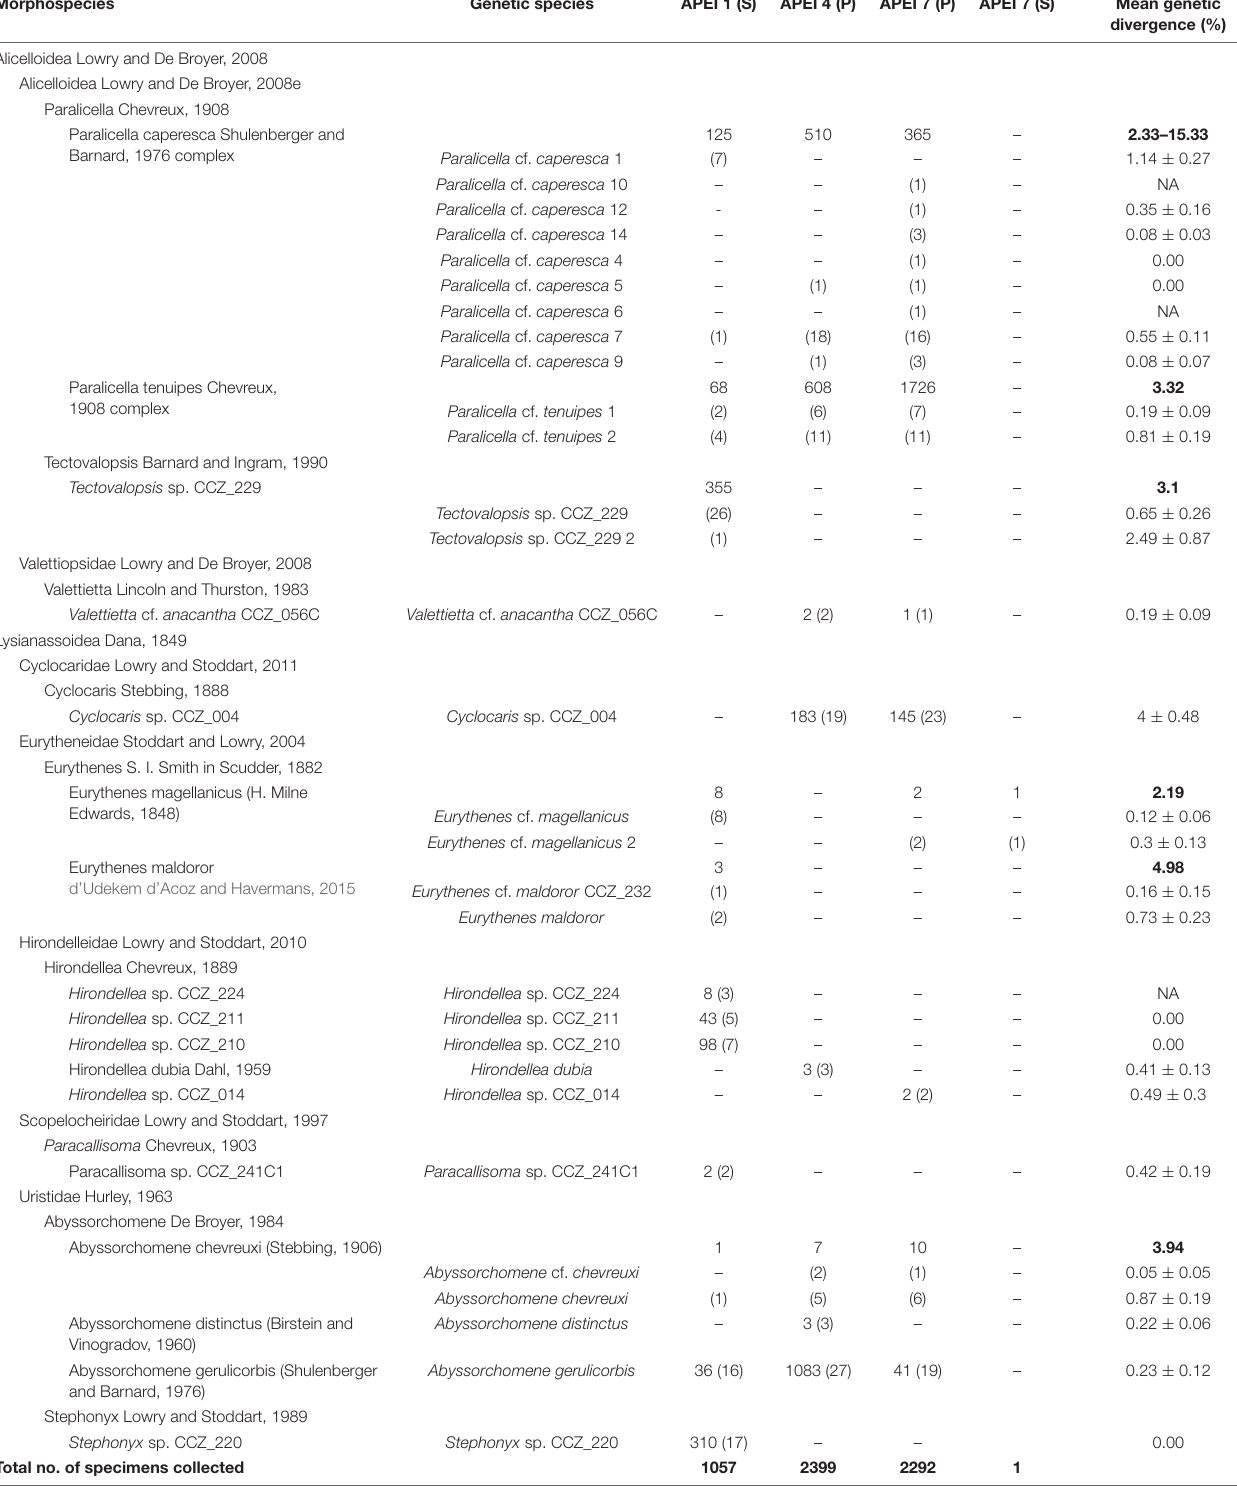
TABLE 1 | Morphospecies and genetic species of scavenging amphipods found in the Areas of Particular Environmental Interest (APEIs) 1, 4, and 7. Morphospecies Genetic